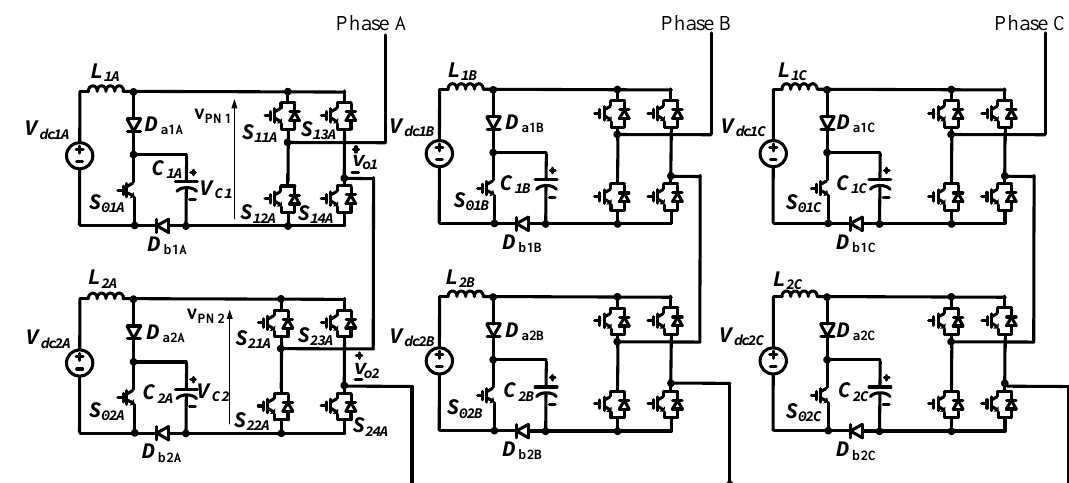
Figure 3. Proposed three-phase CHB quasi-switched boost inverter (CHB-qSBI) topology.